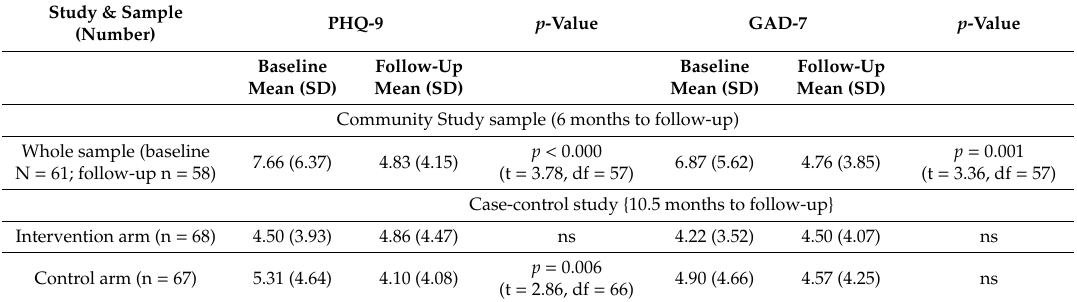
Table 1: Descriptive statistics for the PHQ-9 and GAD-7 for the community study and the case-control study (intervention arm and control arm): numbers, group means (standard deviations) at baseline and follow-up, and paired t -test significance